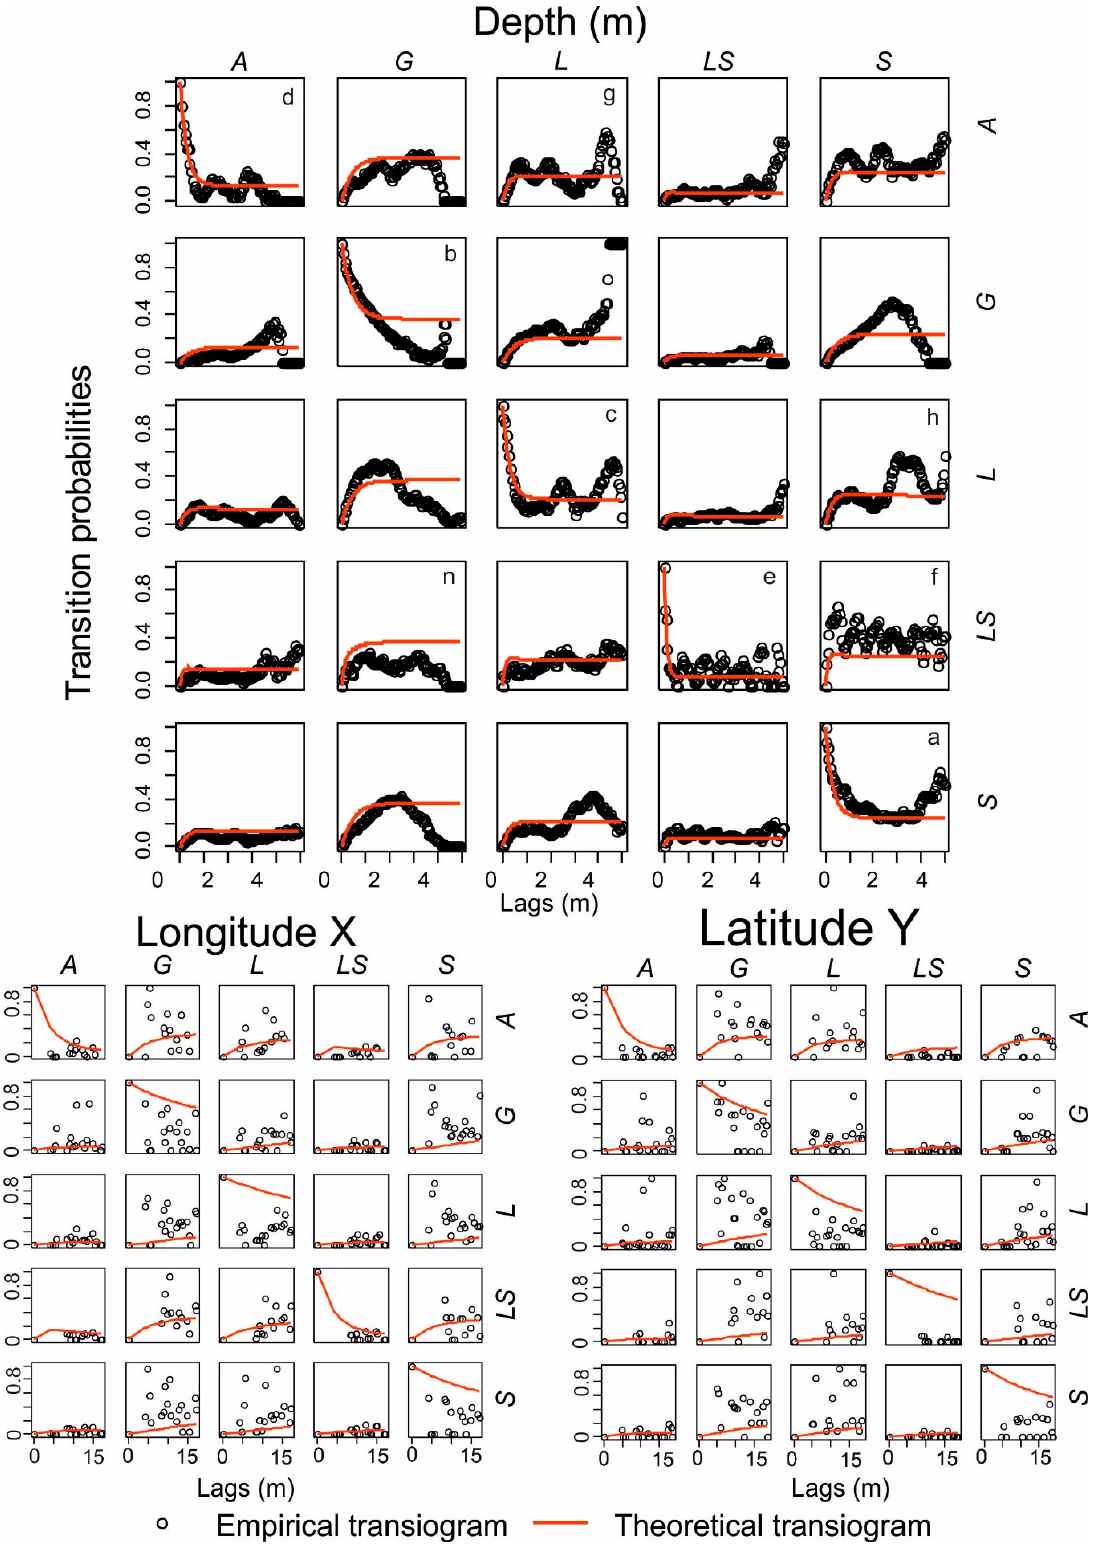
Figure 4. Experimental transition probabilities with respect to the distance (h) (black circles) and theoretical transition probabilities modeled by Markov chains (red lines) along the directions Z, X and Y).